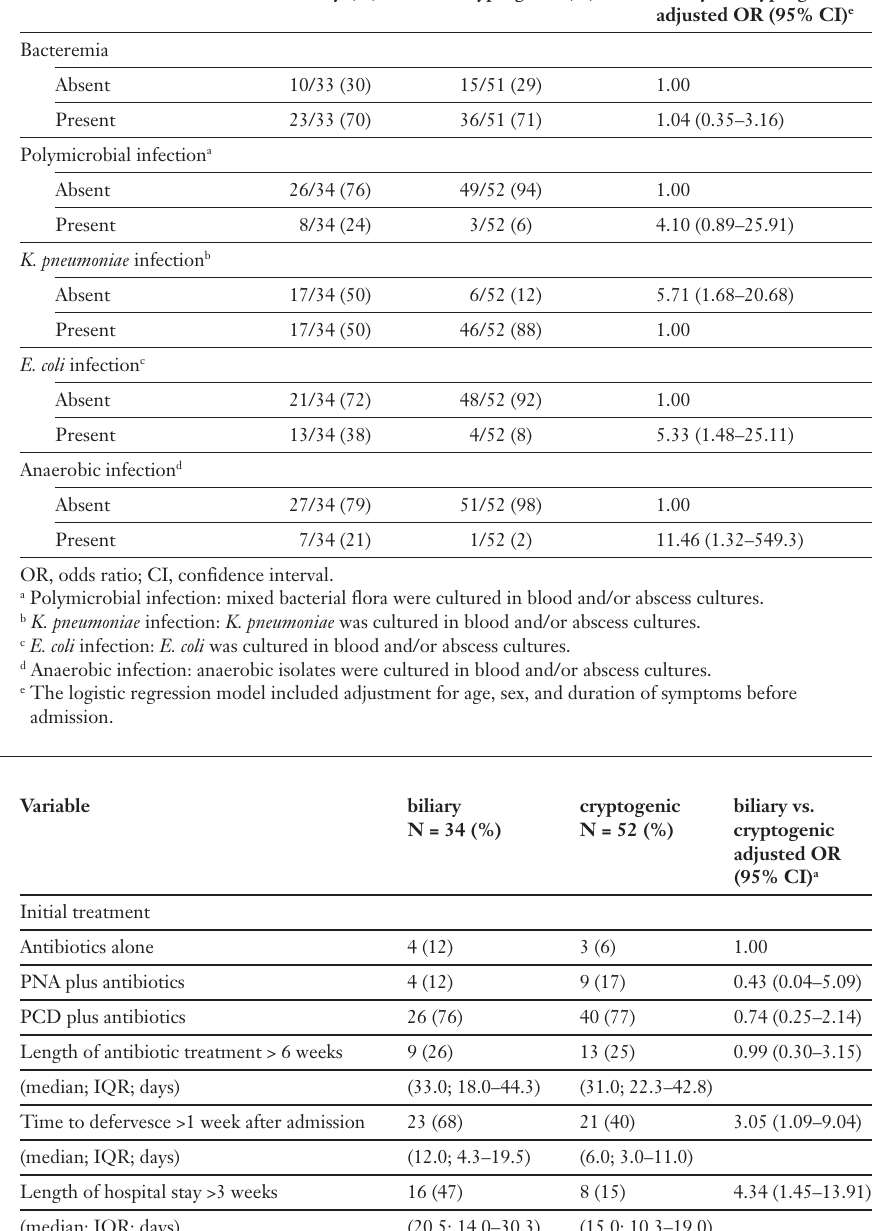
Pyogenic liver ab- scess with regard to specific pathogen in the biliary and cryptogenic groups.